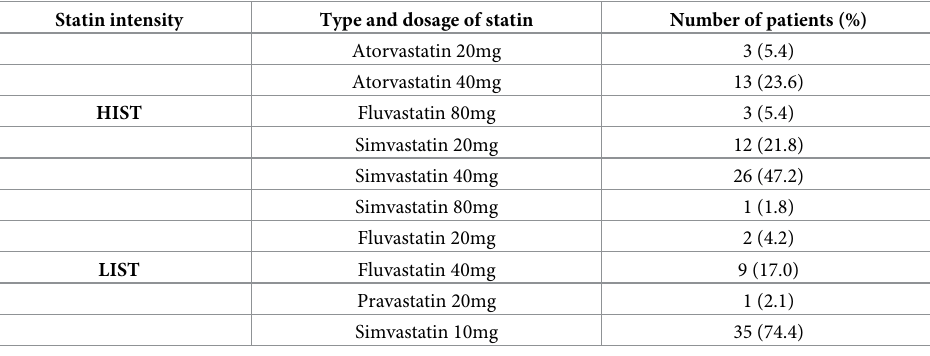
Table 2. Patient allocation to different statin